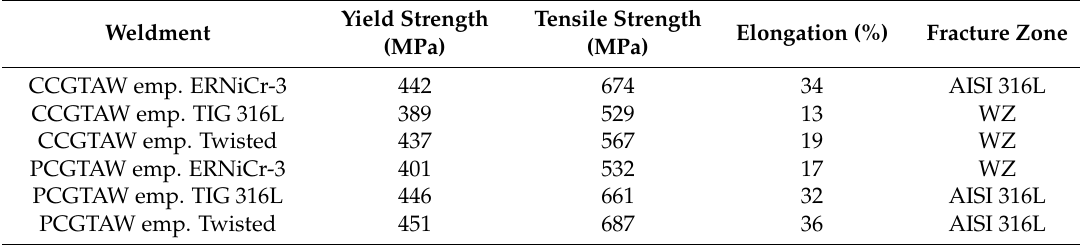
Table 3. Tensile Test Results of CCGTAW and